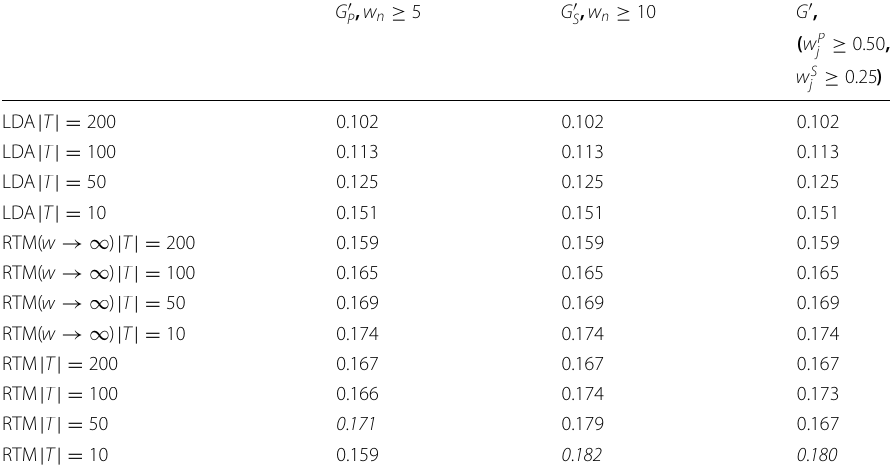
and G ′ in the cutting